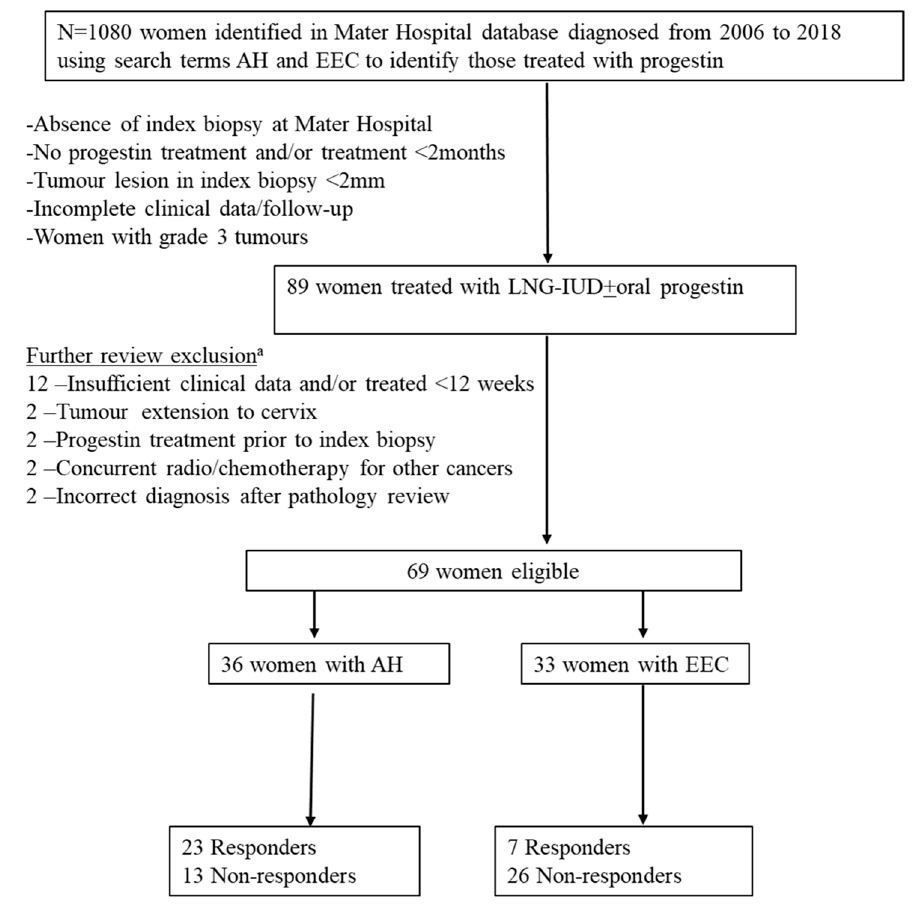
Figure 2. REMARK flow chart of the cohort. a : 20 women were excluded on further review of the 89 cases. AH, atypical hyperplasia; EEC, endometrioid endometrial carcinoma.